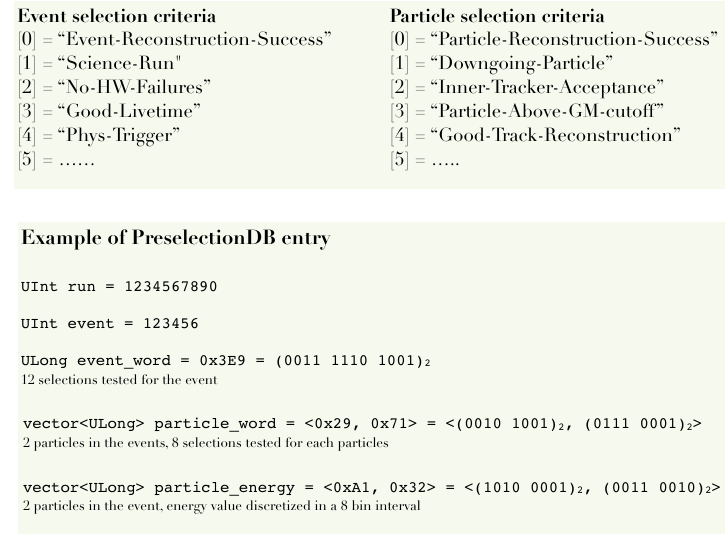
Figure 4. Simplified concept of the database structure developed for the analysis of AMS